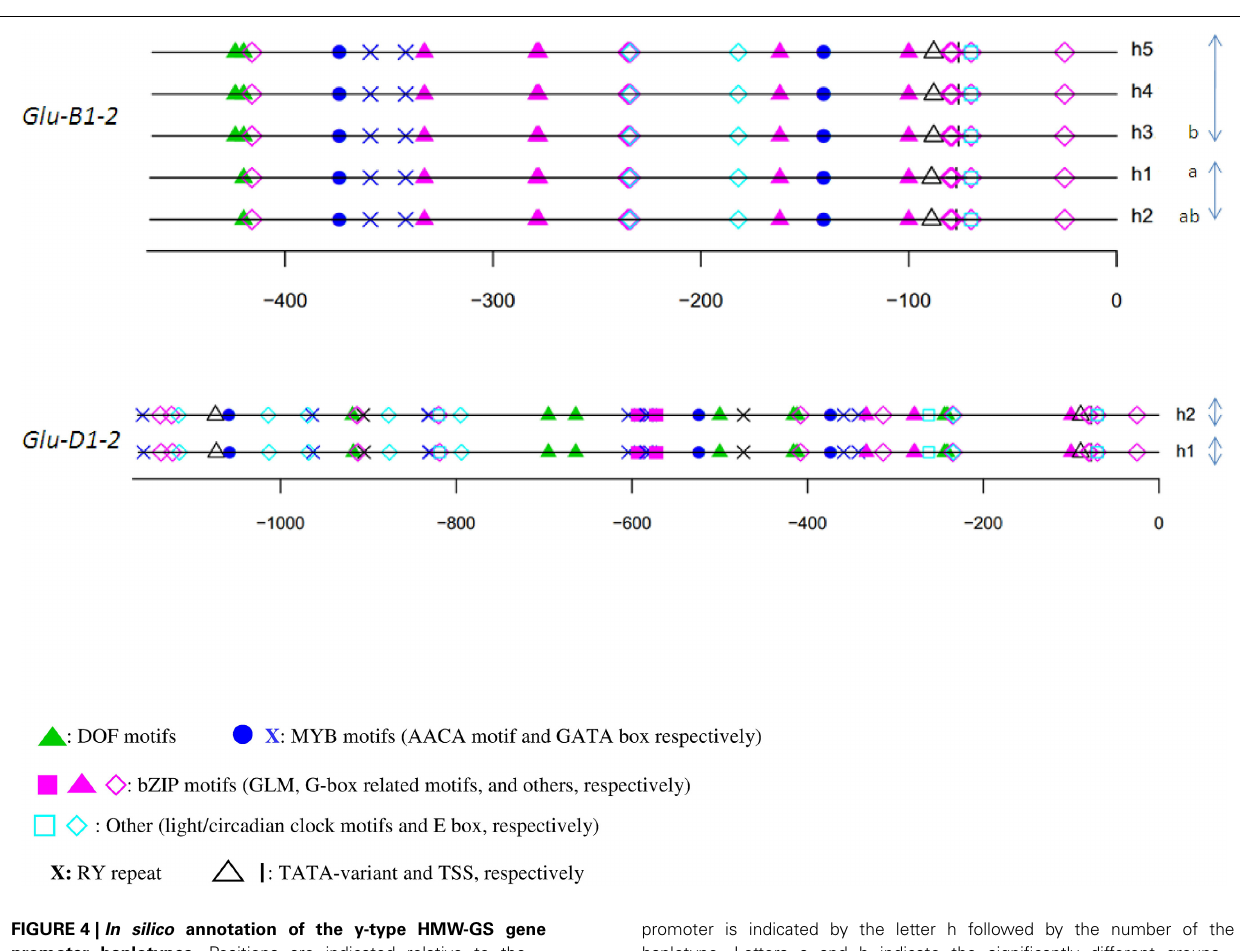
promoter is indicated by the letter h followed by the number of the haplotype. Letters a and b indicate the significantly different groups for the mean of expression for haplotypes studied by qRT-PCR. Clusters of haplotypes differing by one polymorphism are shown with gray arrows on the